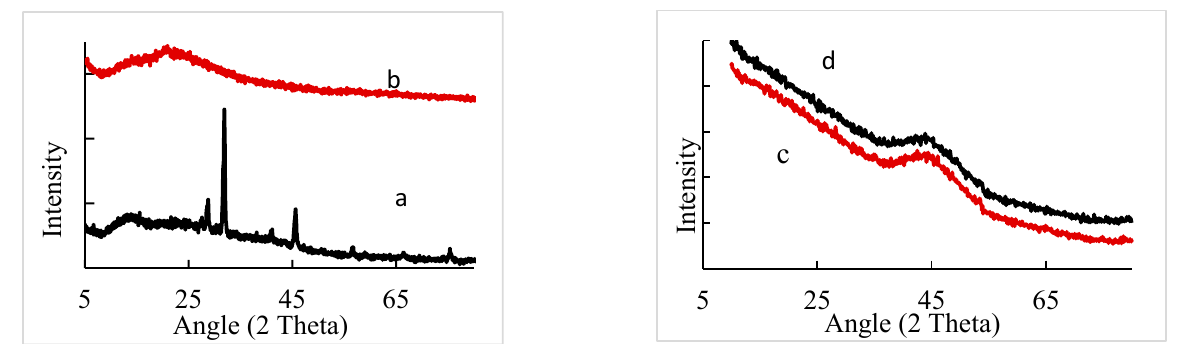
Figure 3. XRD patterns of Ca-Alg 2 (a), Ca-Alg 2 -CH (b), Ca-Alg 2 -CH/CPT (c), and Ca-Alg 2 /CPT (d).